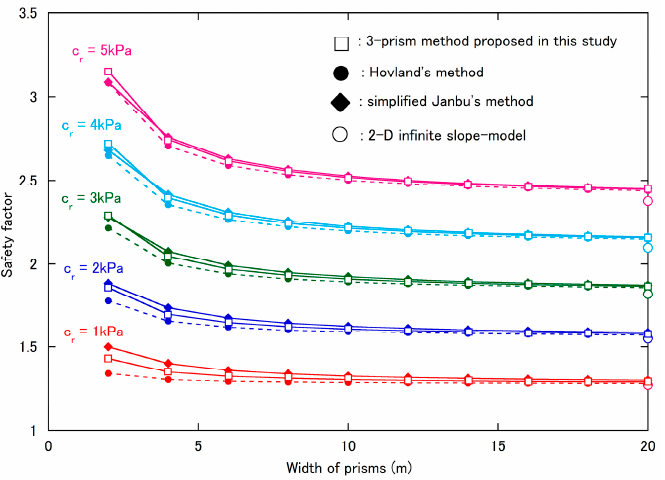
Figure 6. Comparison of safety factors according to prism width evaluated using different analysis